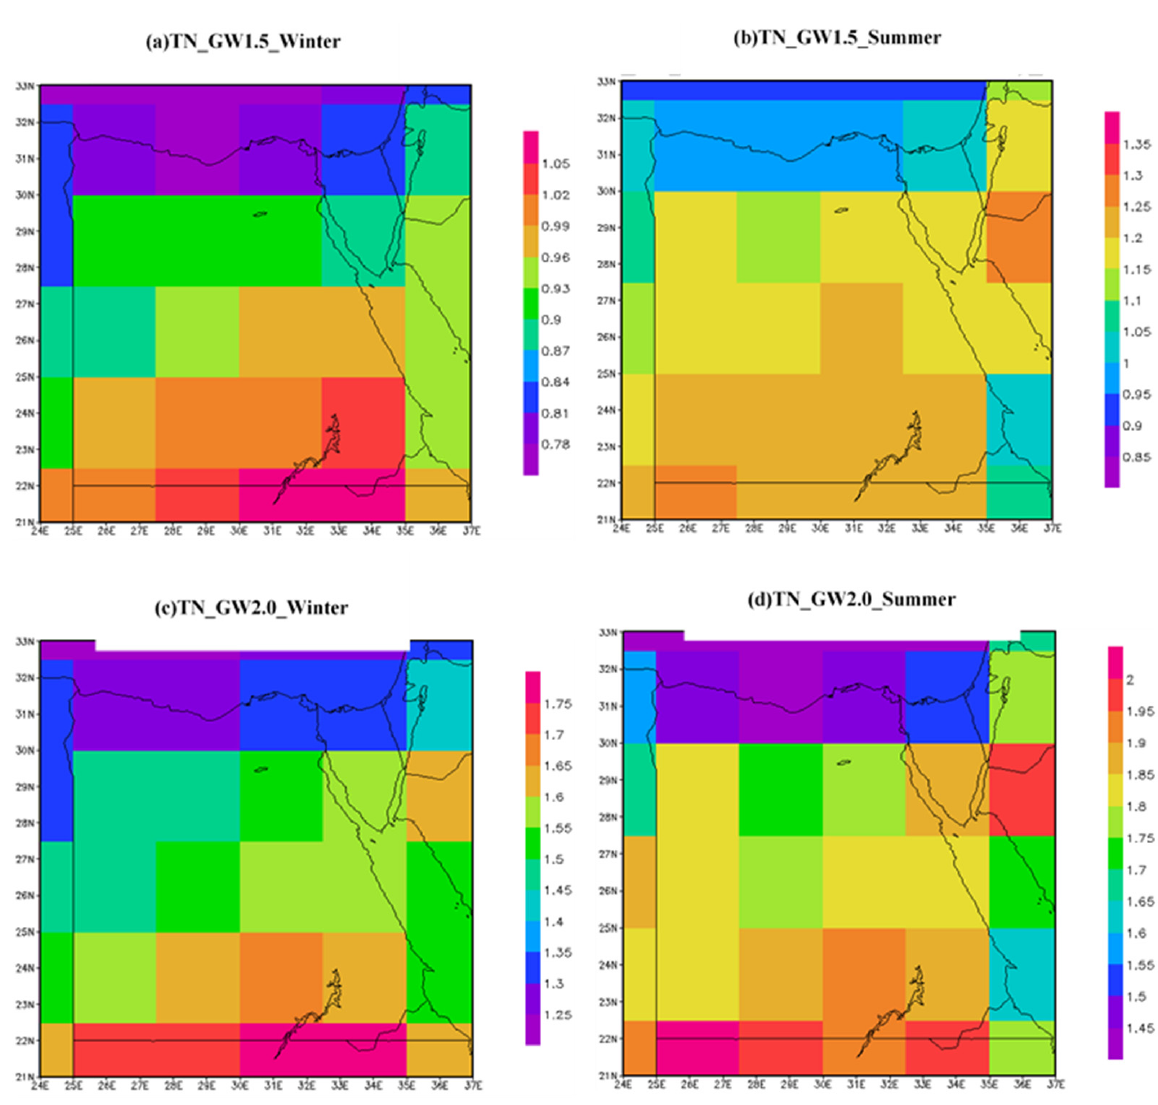
Figure 4. The seasonal absolute difference of minimum temperature for, ( a ) winter (TN) for GW1.5, ( b ) summer TN at GW1.5, ( c ) winter (TN) at GW2.0, and ( d ) summer TN at GW2.0.